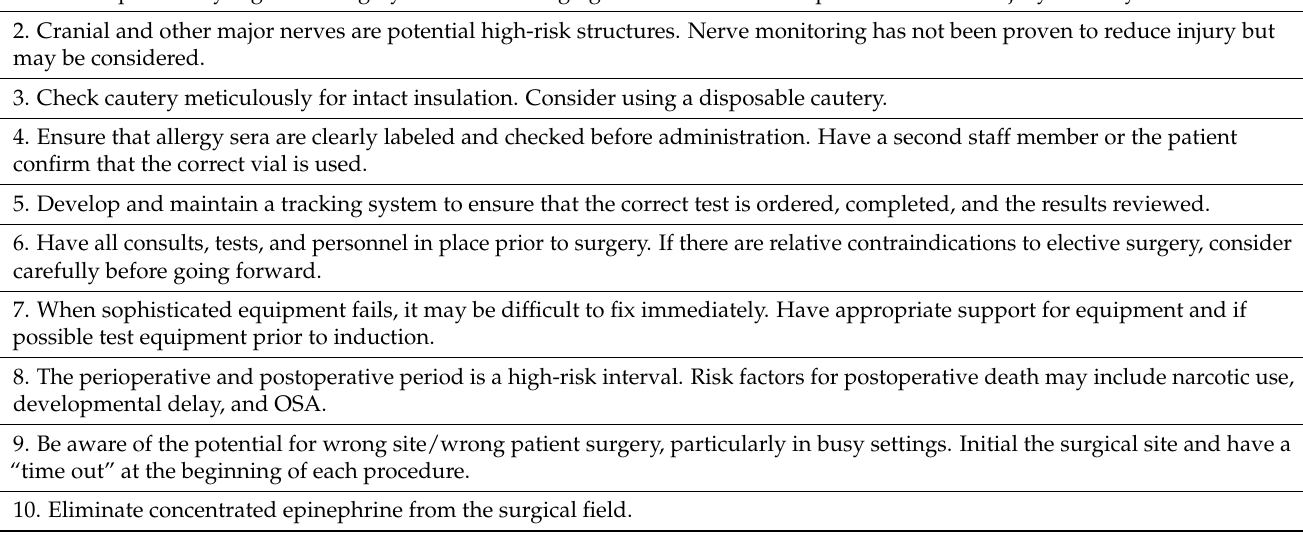
Table 5. The top 10 safety recommendations [58]. Abbreviations used: ESS, Endoscopic Sinus Surgery; and OSA, Obstructive Sleep Apnea. Reprinted with permission from Ref. [58]. 2004 Wiley Online Library.